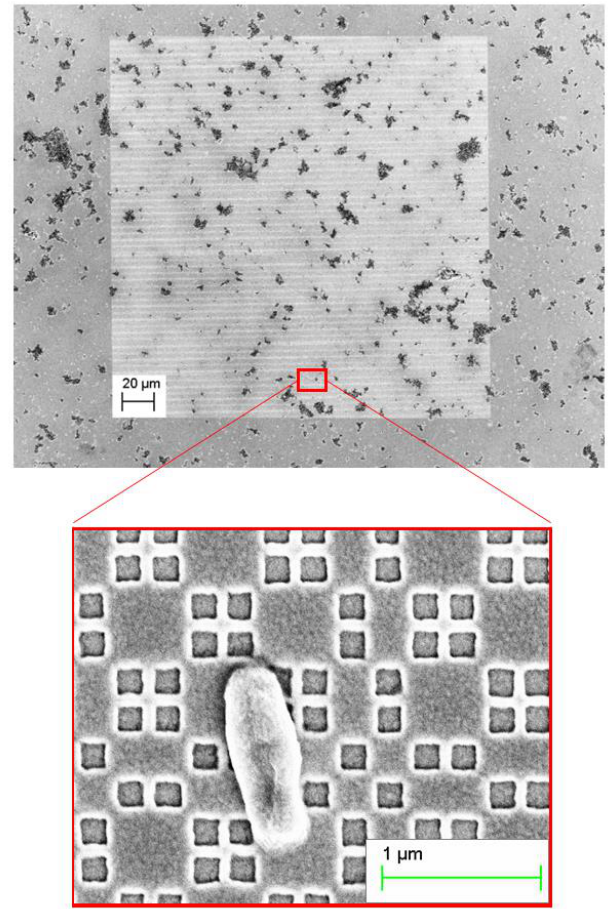
Figure 3. Morphological characterization of the nanostructures by SEM. Detailed image of the structure showing a cell of Brucella abortus is highlighted in red. Structure measures are distance of a = 50 nm, and side size of d = 185 nm with increasing edge-to-edge distances from 25 to 100 nm.